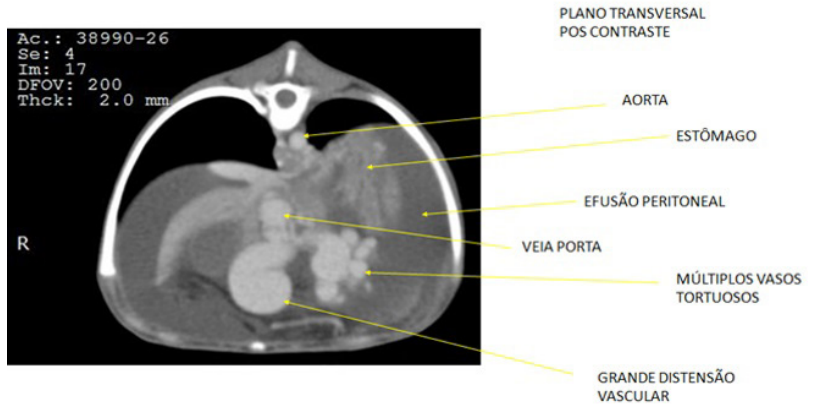
Figura 3. Imagem da tomografia contrastada feita no plano transversal, que indica a presença de hipertensão portal, efusão pleural e fístula arteriovenosa hepática.